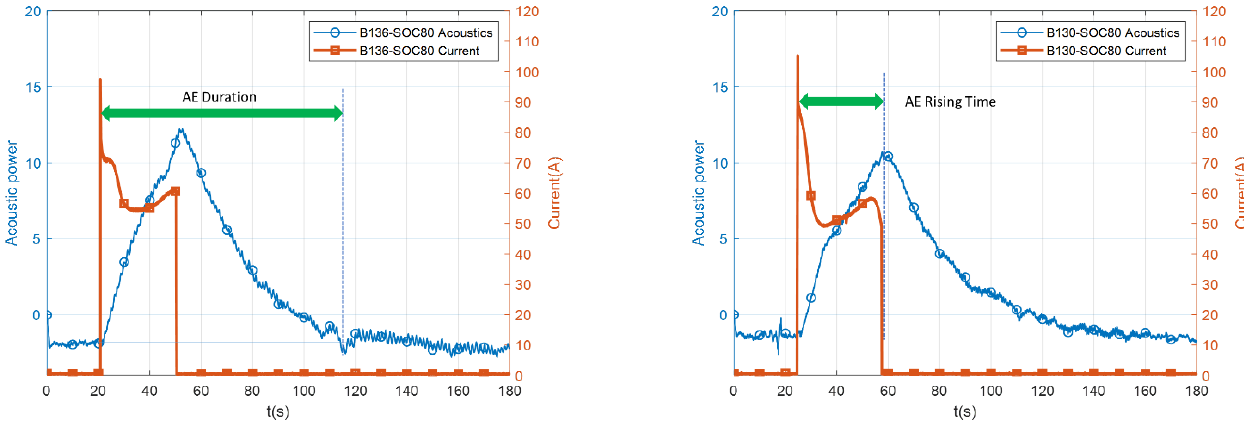
Figure 7. Current and acoustic characteristics of ESC with initial SOC80 condition.